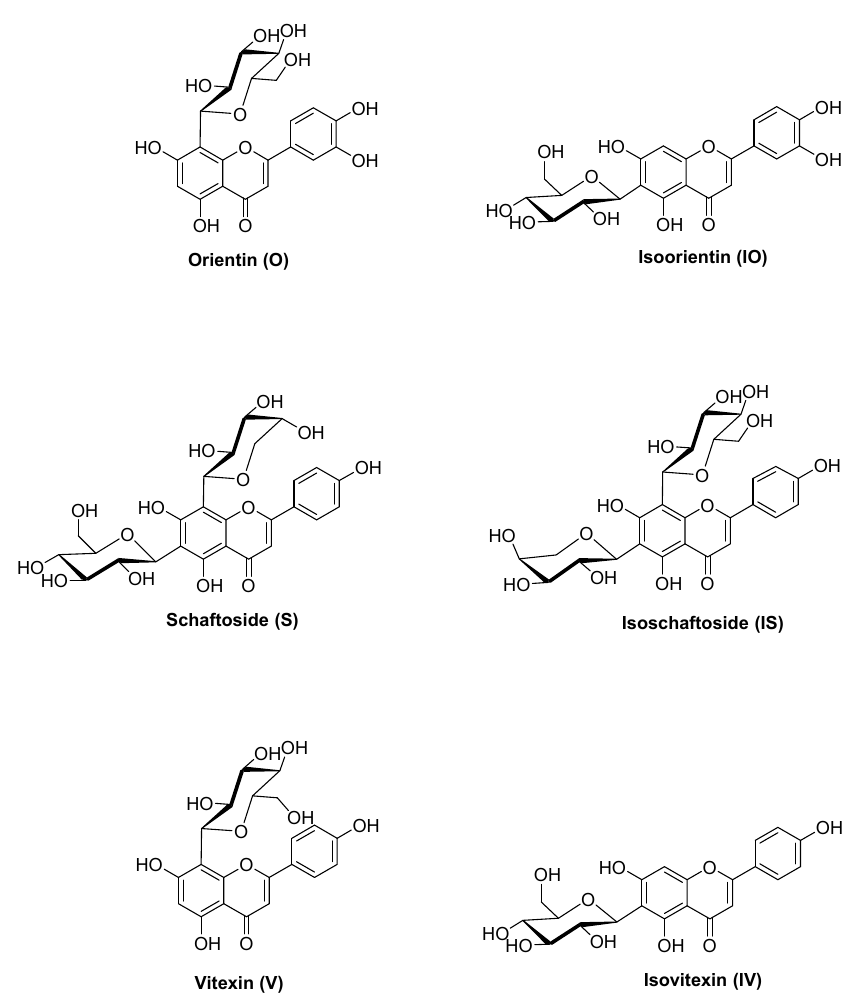
Figure 1. Structures of the C-glycosidic flavonoids orientin (O), isoorientin (IO), schaftoside (S), isoschaftoside (IS), vitexin (V), and isovitexin (IV).